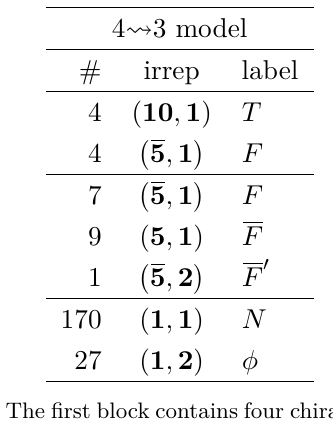
Table 3. Summary of the SU(5) × SU(2) s quantum numbers of the (left-chiral) massless matter spectra of heterotic orbifold models with (a) 4 3 and (b) 2 3 SU(5) generation flow. These models have (a) four and (b) two chiral generations at tree level, respectively, but three chiral generations in the low-energy effective description due to SU(2) strong dynamics. The second (third) block of s each table consists of states that are vector-like (invariant) under SU(5)